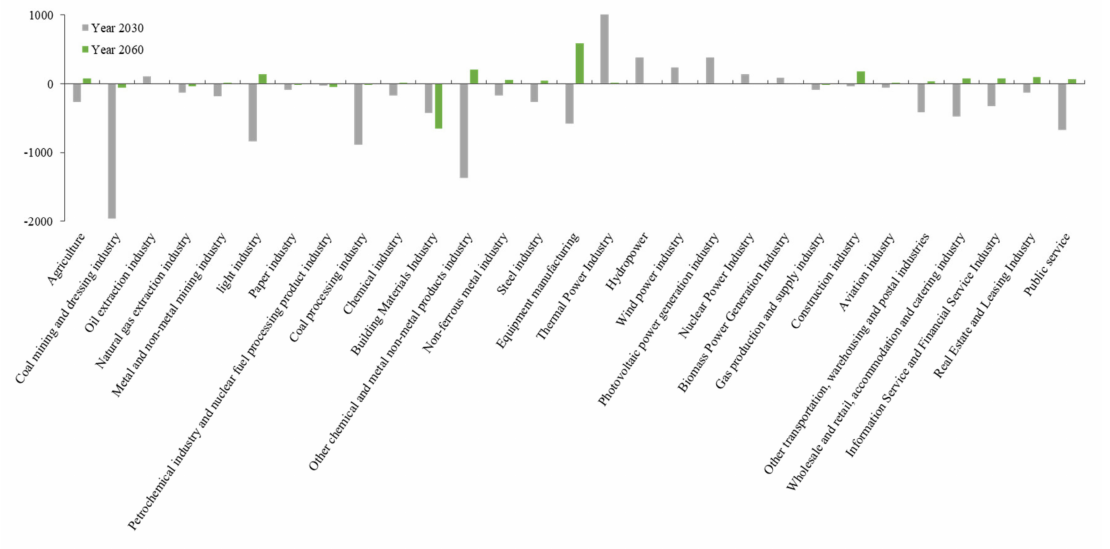
Figure 10. Changes in output of various industries compared with BAU under S2 scenarios in 2030 and